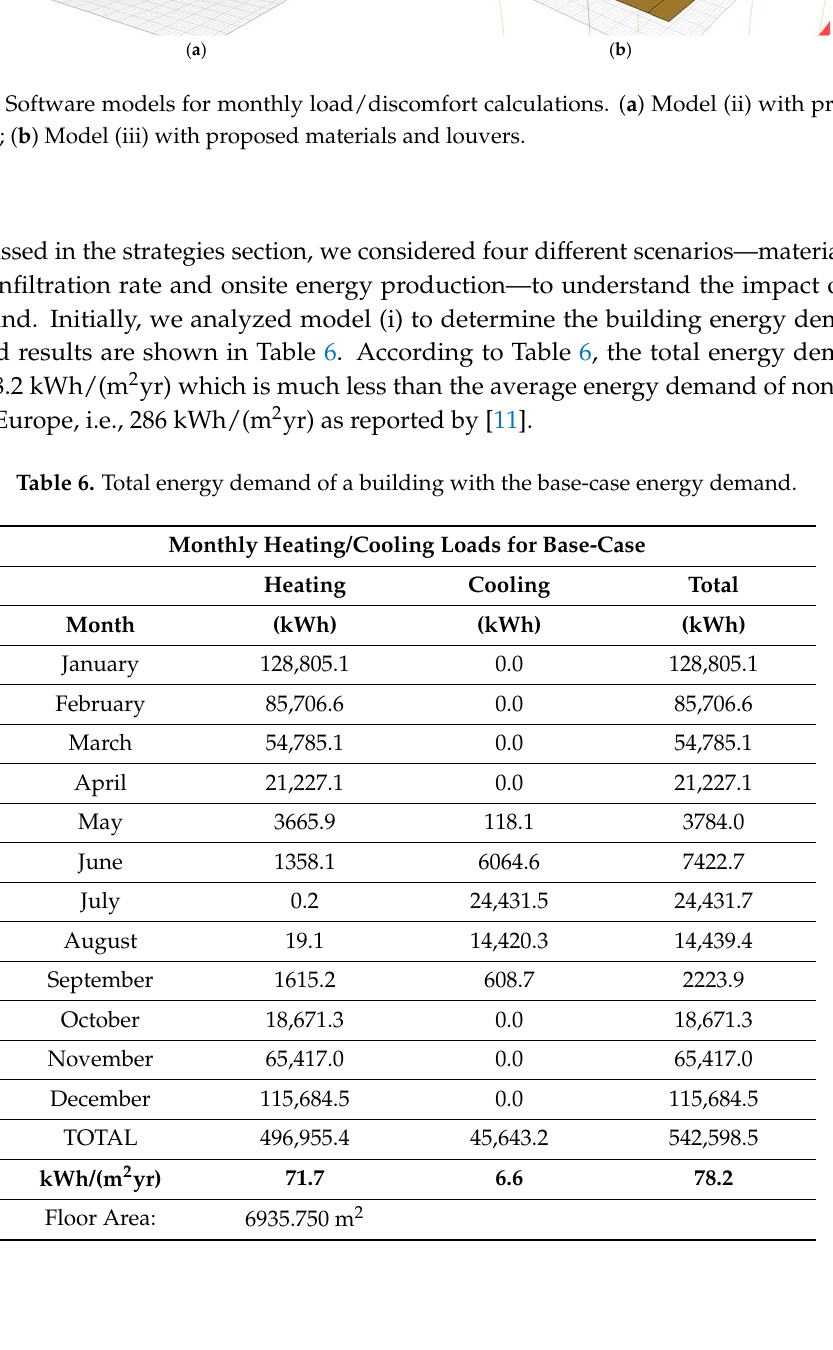
materials; ( b ) Model (iii) with proposed materials and louvers.